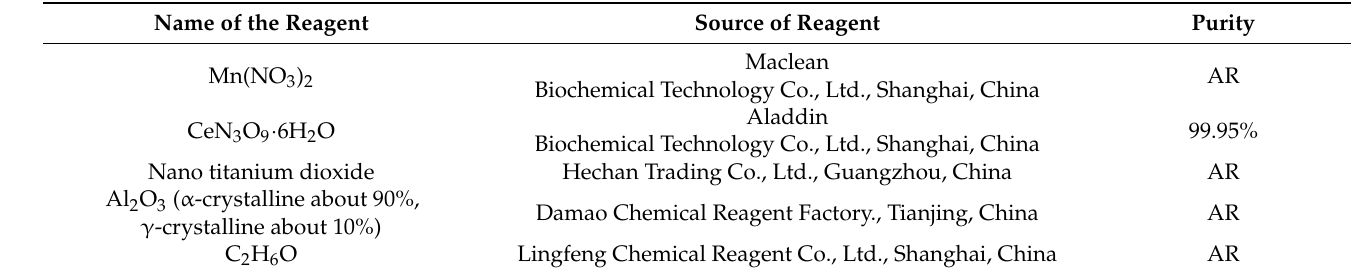
Table 1. Reagents used in the experiments and purity.